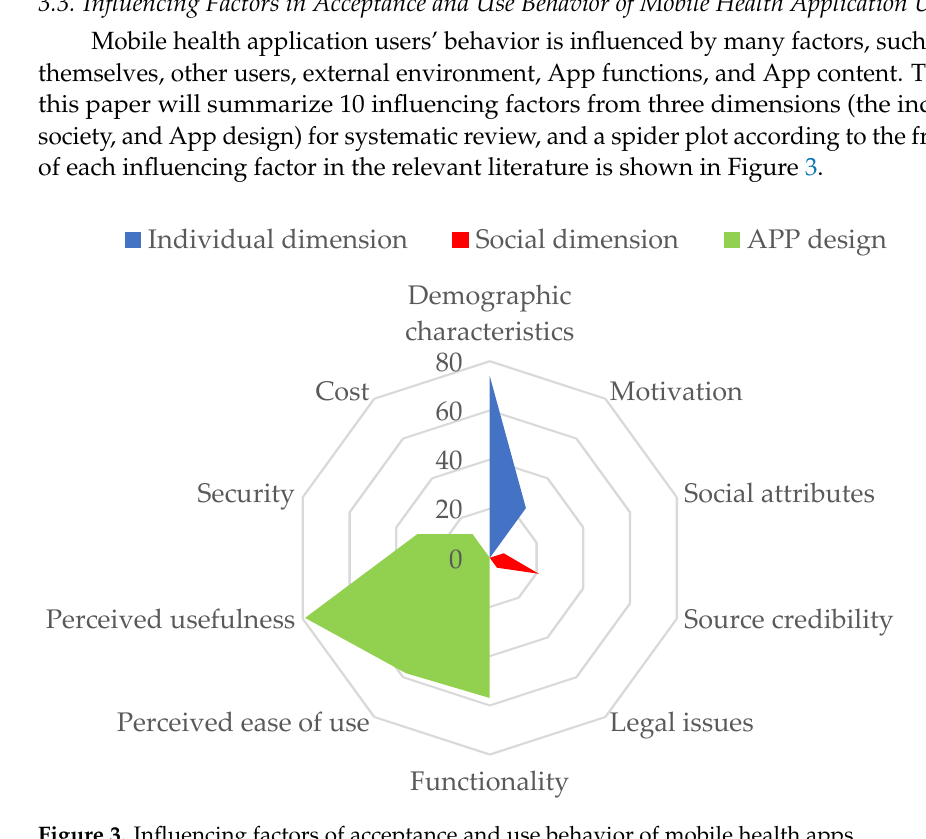
Figure 3. Influencing factors of acceptance and use behavior of mobile health apps.